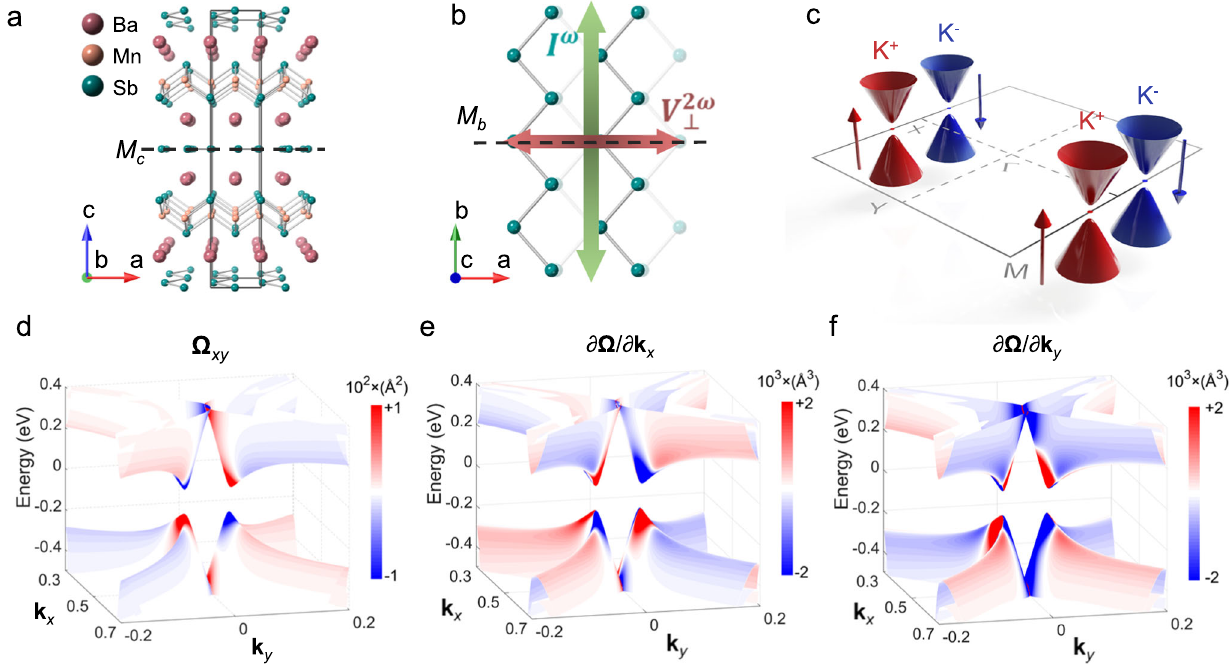
b -axis generates a second-harmonic Hall voltage V 2 ω a -axis. ? response along the c The schematic of the spin-valley locked Dirac cones located at K + and K - near the X-point,withthespinprojectionbeingcolor-coded(red,spin-up;blue,spin-down). d – f ThecolormapsoftheBerrycurvature( Ω xy )andthe fi rstpartialderivativeofthe , ∂ Ω ∂ ) around the X-point where two massive Dirac cones Berry curvature ( ∂ Ω ∂ k x k y